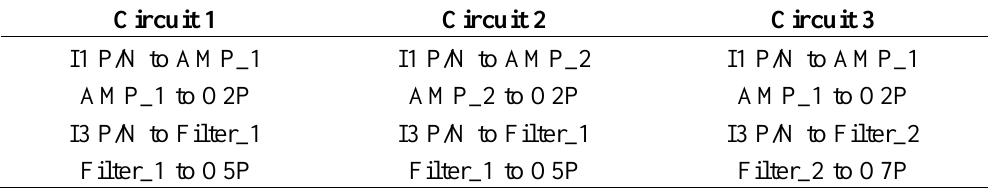
Table 3. Circuit configurations of FPAA-based self-healing WSN node.